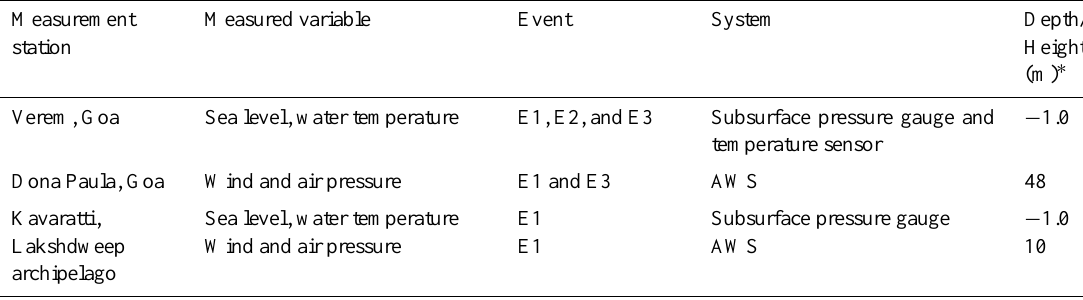
Table 1. Summary of observations.